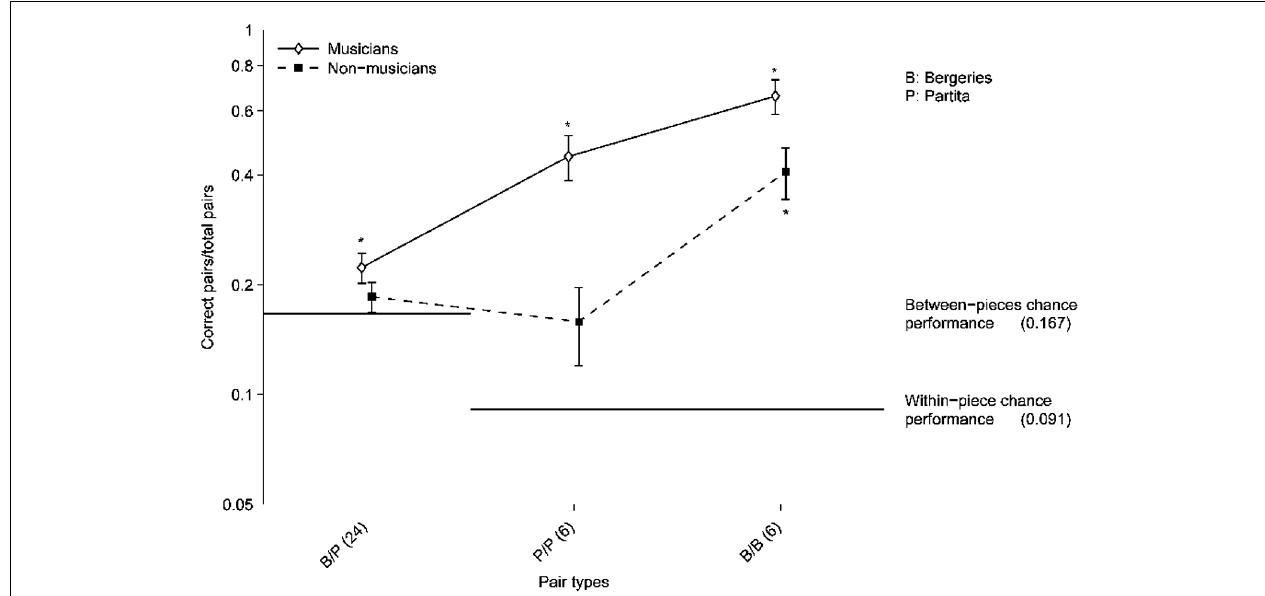
excerpts from the same performer (B/B). Error bars indicate standard errors of the mean. Asterisks indicate values that are significantly different from chance performance (for both musicians and non-musicians) as determined by one-tailed t -tests with Bonferroni correction. Points are connected to help distinguish the two participants group